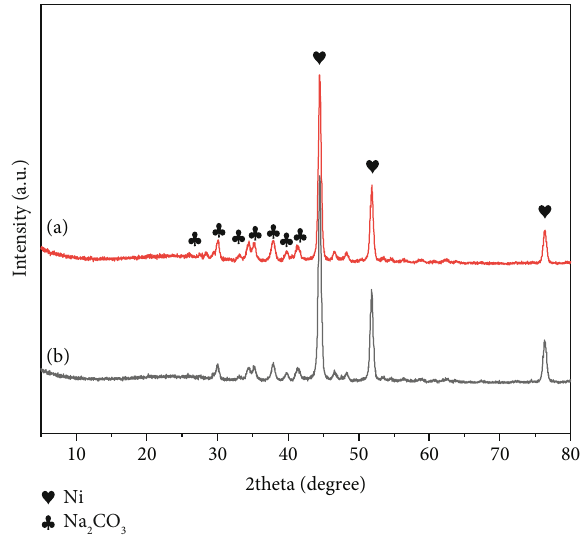
Figure 7: XRD patterns of the DW-Ni-700catalyst: (a) fresh DW- Ni-700 and (b) reused